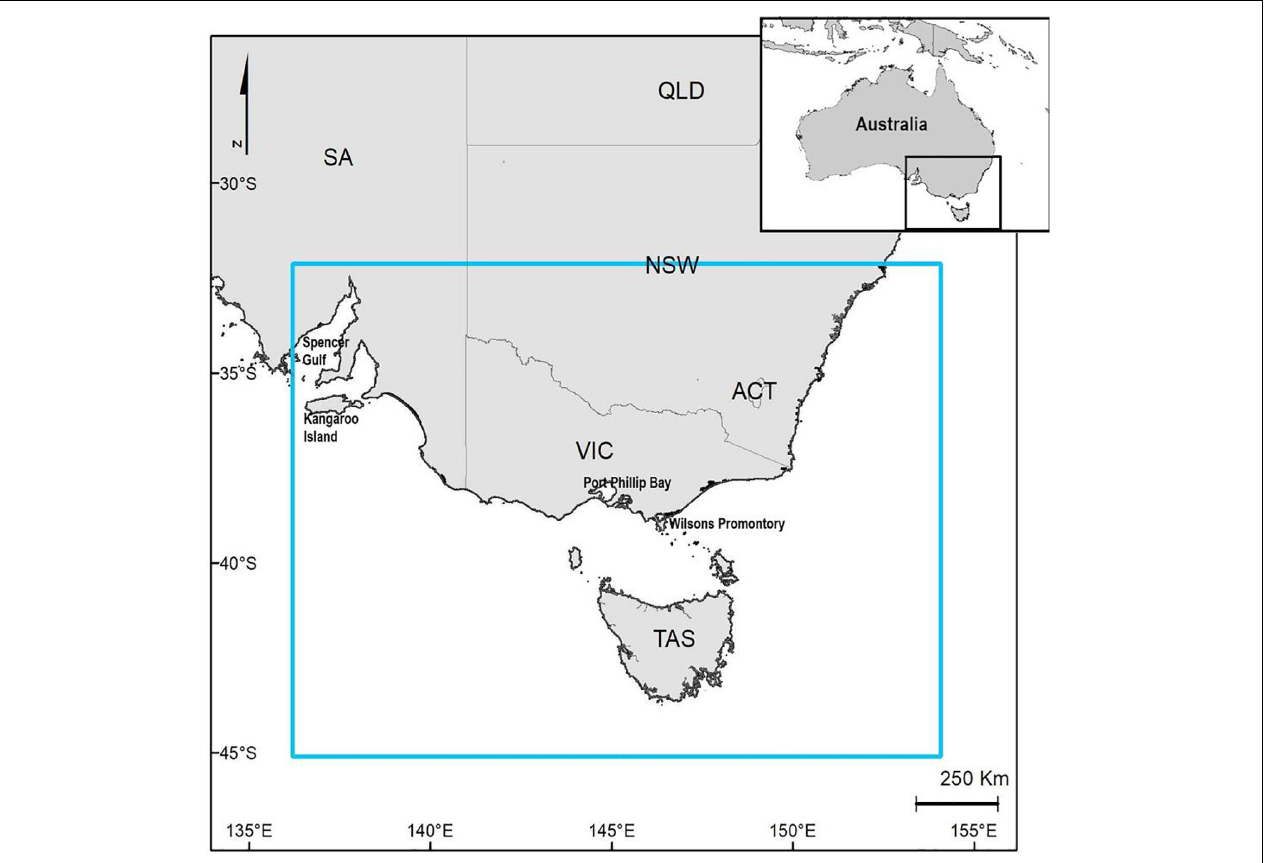
FIGURE 1 | Map of the study